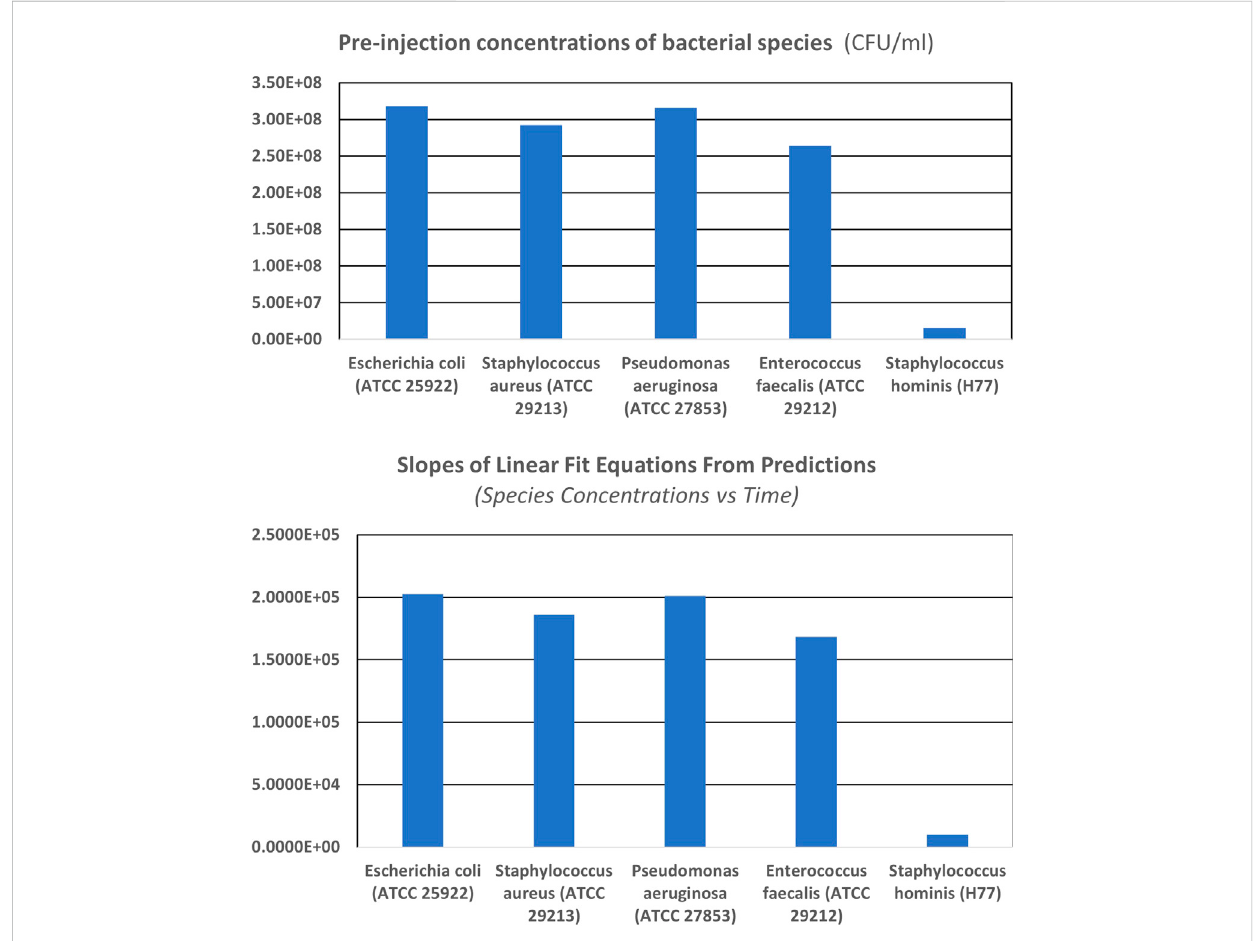
Pre-injection concentration ( CFU / ml ) plot of the individual species in Mixture 1 (top) and the plot of the slopes of the linear fi t equations (of species concentrations( CFU )asafunctionoftime)frompredictionsfor Mixture1 ,computedbythemachinelearningalgorithmbasedonthebackscattereddata from AUM system (bottom). The predicted slopes of the linear fi t equations of species concentrations as a function of time are consistent with the pre- injection concentrations of the individual species of the Mixture 1. The linear goodness of fi t, ( R 2 ) values of predictions are greater than